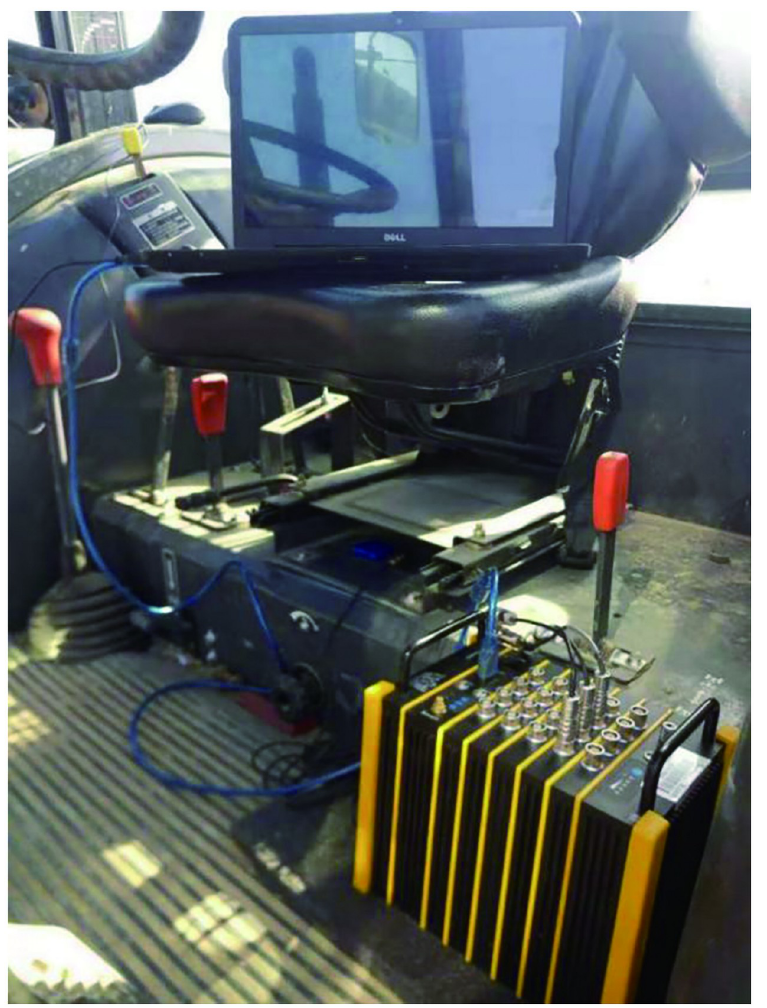
Fig 2. Arrangement of collection